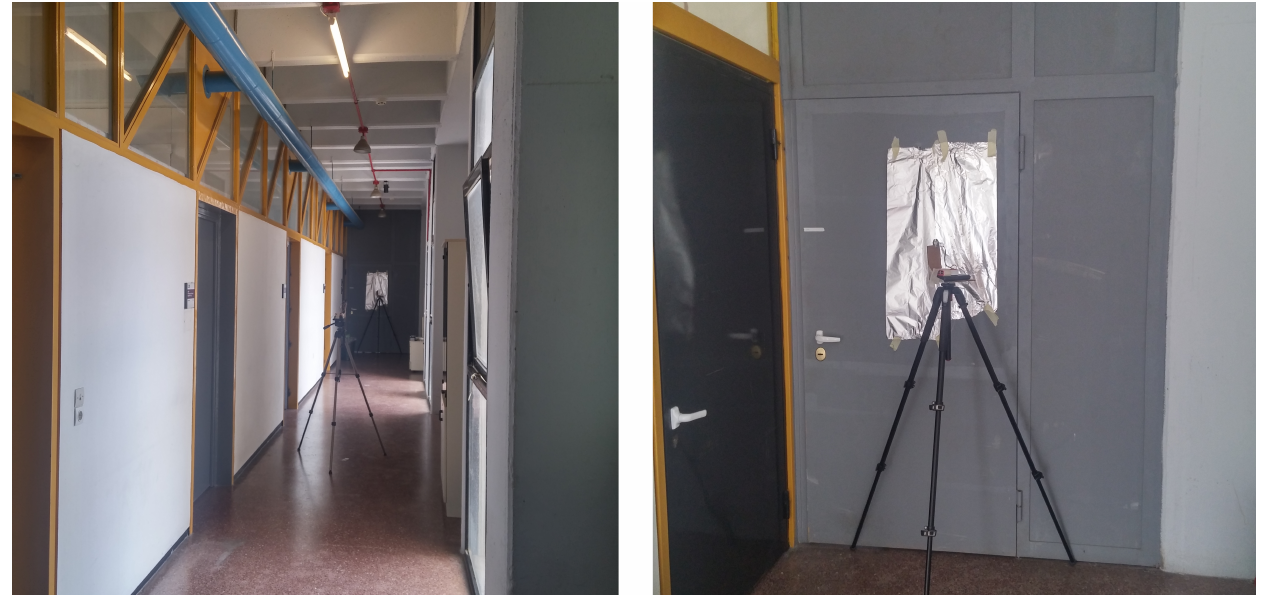
Figure 8. ( Left ) Measurement setup to investigate the effect of multipath on the performance of the UWB transceivers. The two transceivers are placed on top of tripods, with one being stationary in front of the door and the second moved along the corridor to take distance measurements at various distances. ( Right ) Close-up of the transceiver in front of the door covered with aluminum foil.